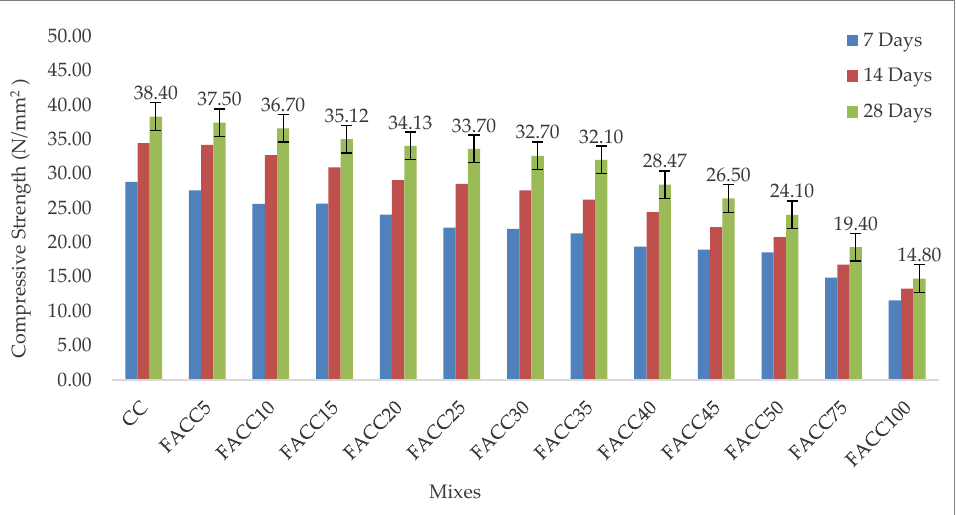
Figure 5. Variation of Compressive Strength with Age for CC and FACC Mixes.